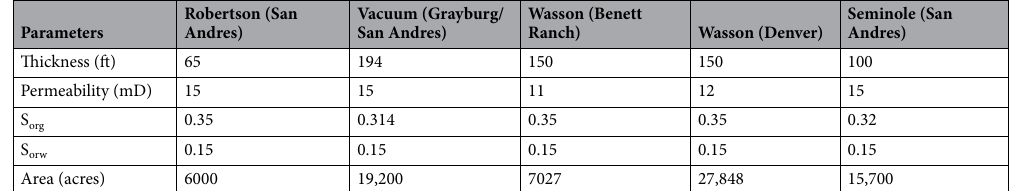
Table 3. The residual oil zones parameters for five fields in the Permian Basin, USA.